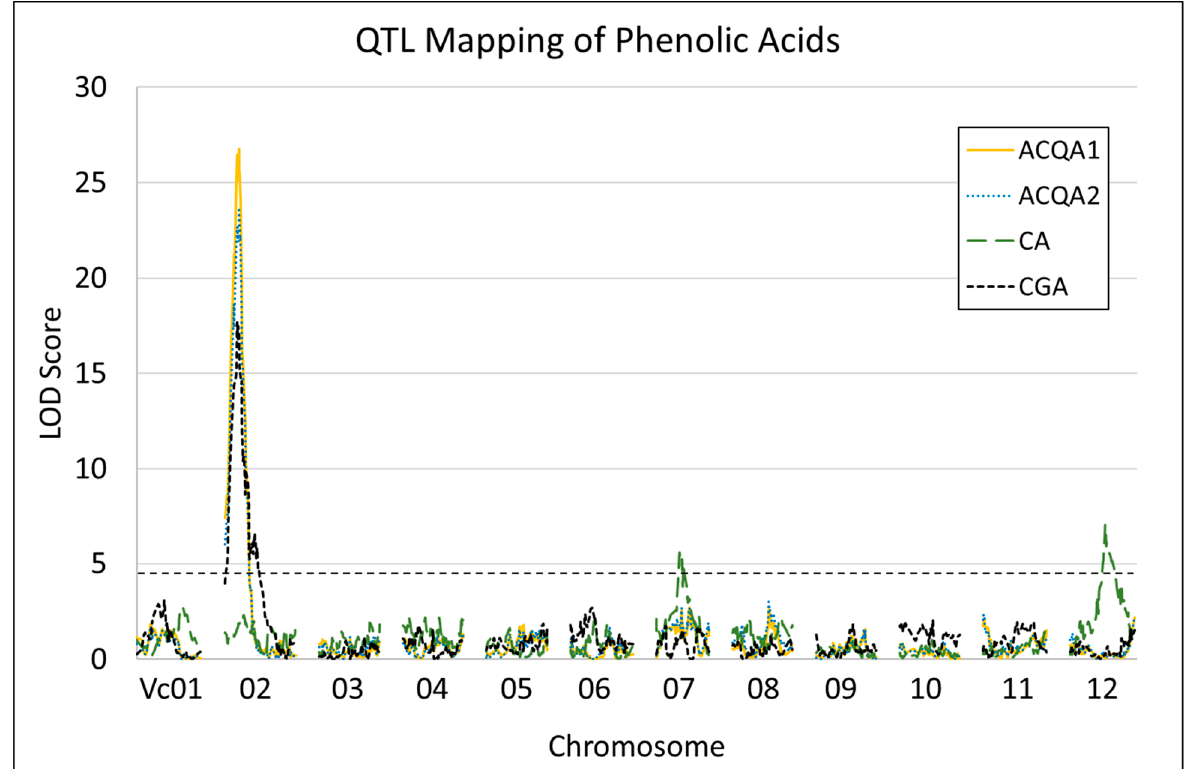
Figure 5. Trait mapping results for BLUPs of the phenolic acids. The horizontal dashed line indicates the significance cutoff (~4.5).